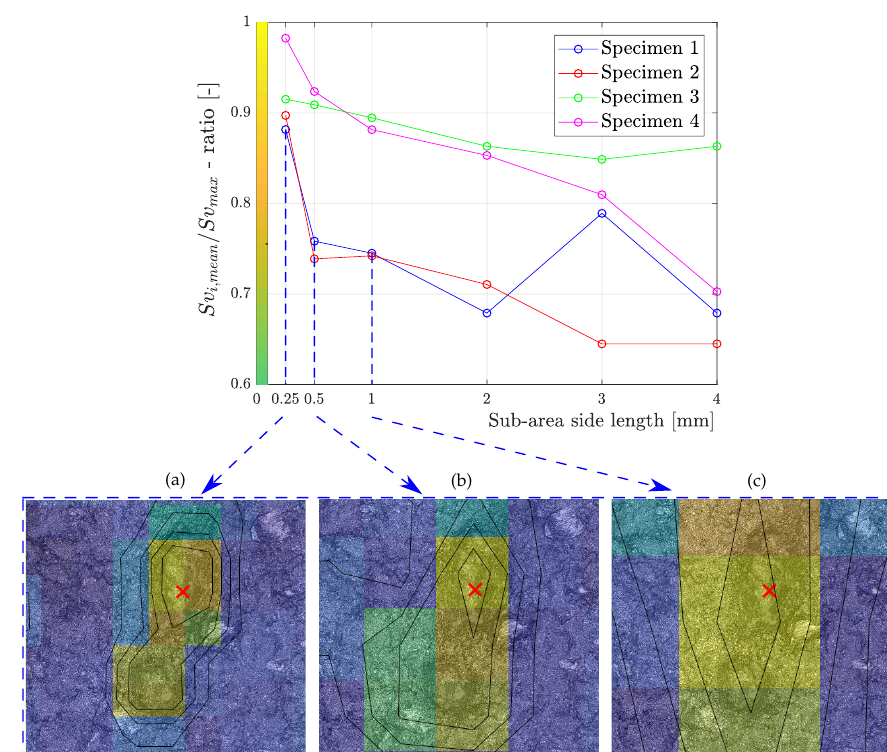
Figure 12. Size effect of ( a ) 0.25 mm, ( b ) 0.5 mm and ( c ) 1.0 mm sub-area side